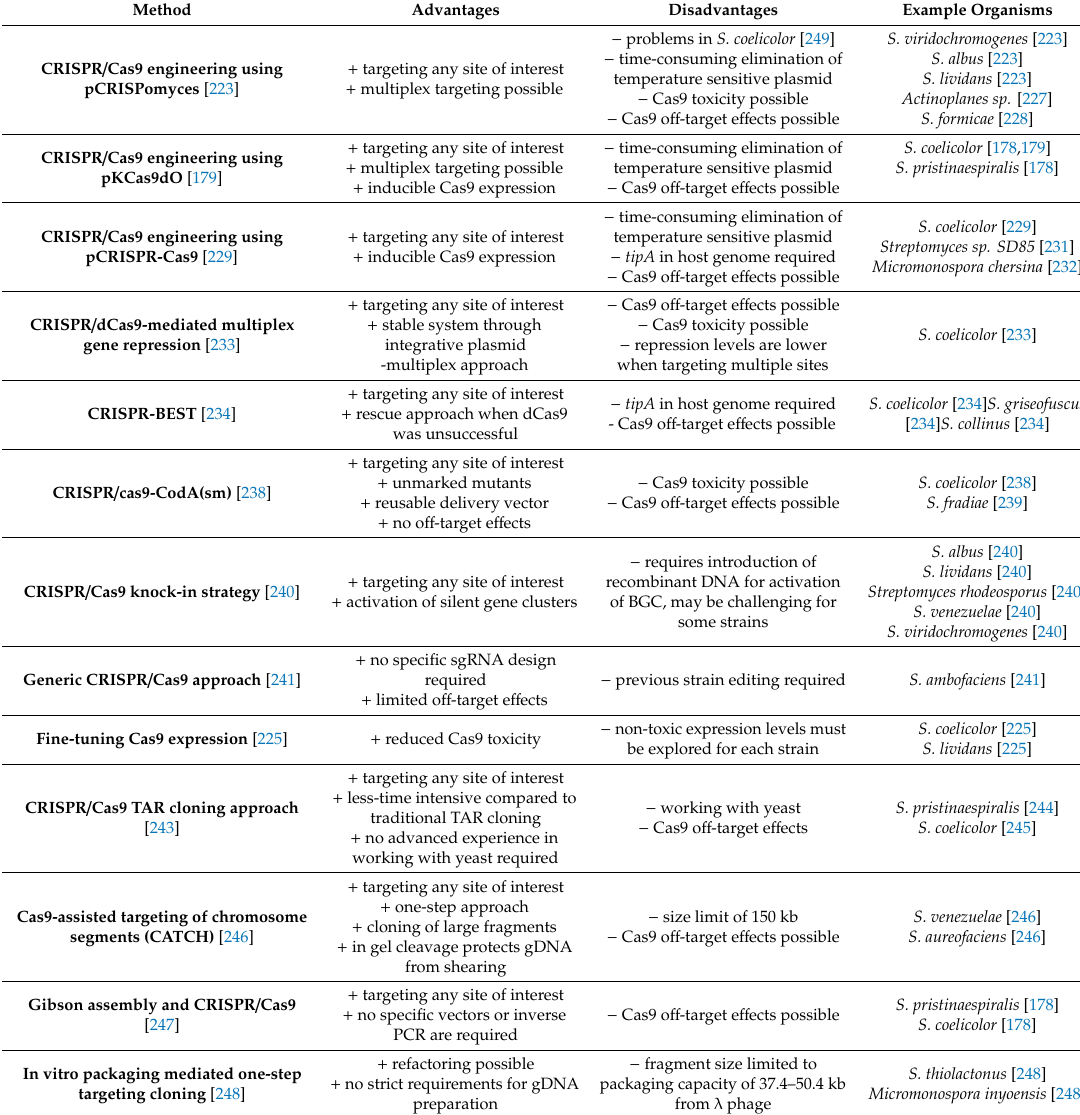
Table 2. Advantages and disadvantages of CRISPR / Cas-based genome editing and examples of successful application in